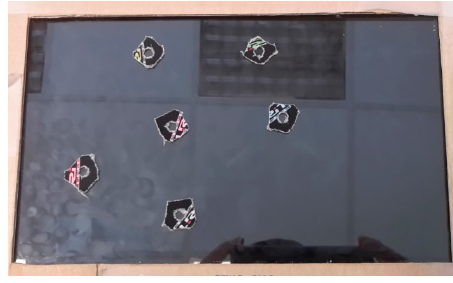
Figure 7. Reconstruction of the configuration with stickers on tablet in sleep mode.